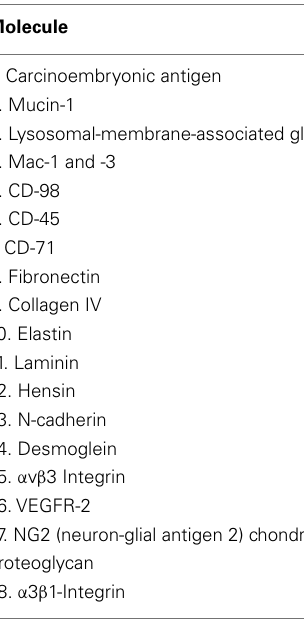
Table 1 | Galectin-3 binding partners